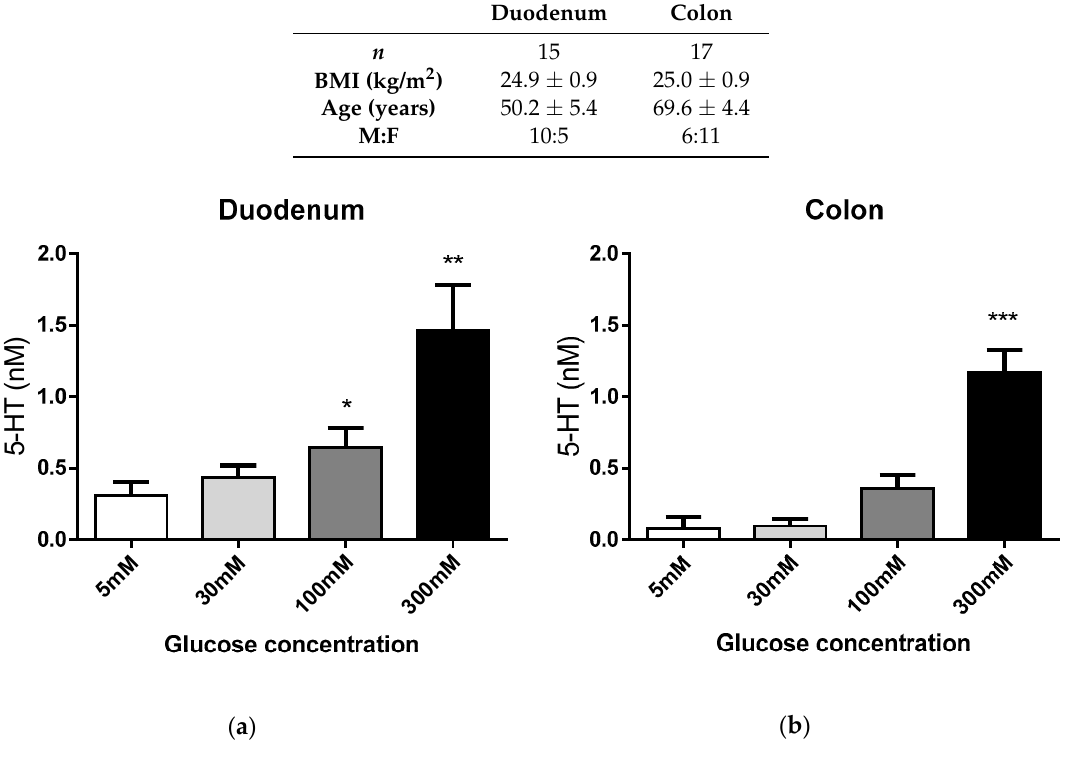
Figure 1. Human enterochromaffin (EC) cells respond to meal-related glucose concentration. Glucose-evoked 5-HT release from EC cells from human duodenum ( a ) and colon ( b ) is dose dependent in response to meal-related (luminal) glucose concentrations. Paired data shown for duodenum ( N = 15) and colon ( N = 17). * p < 0.05; ** p < 0.01, *** p < 0.001.